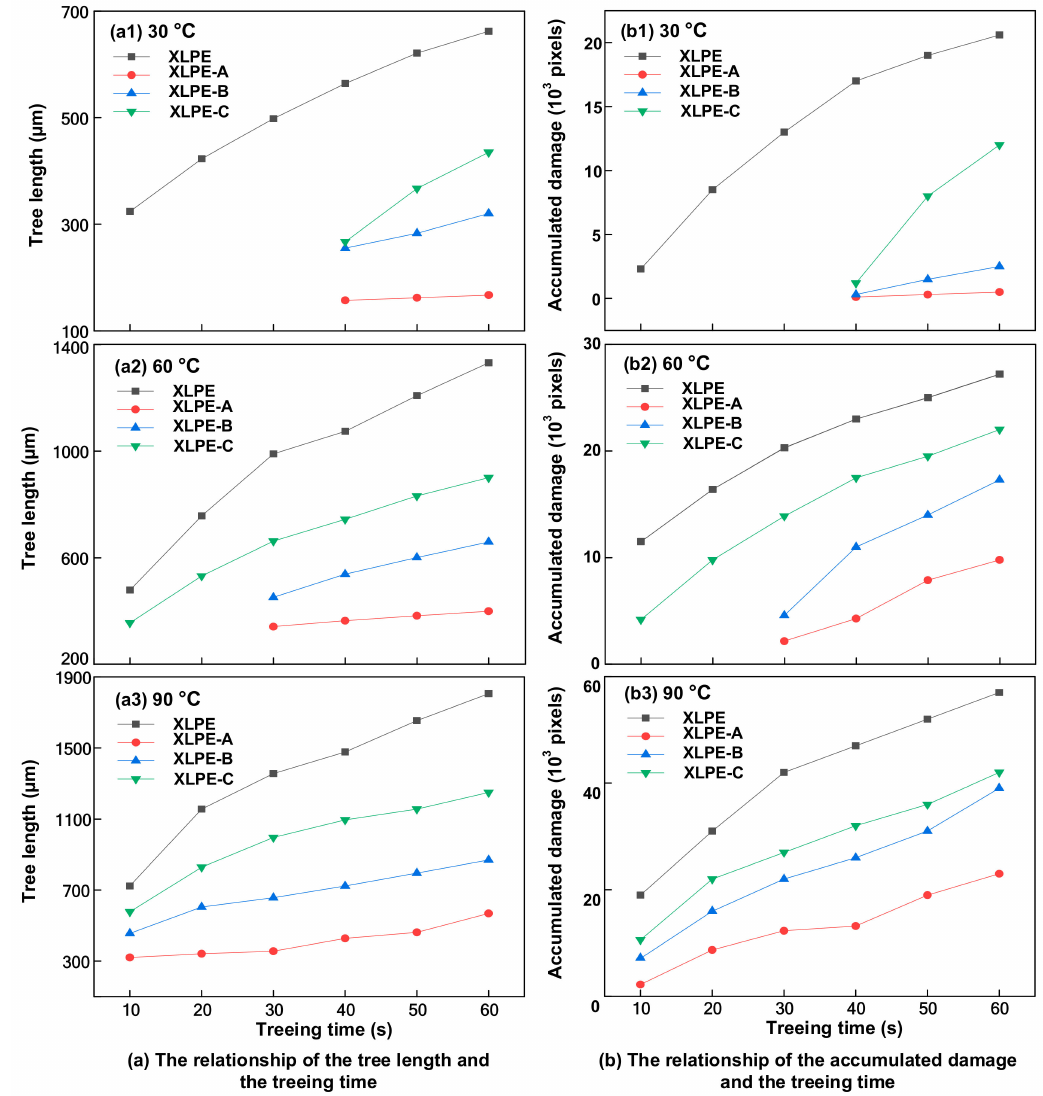
Figure 4. Electrical treeing characteristics with opposite polarity DC-impulse